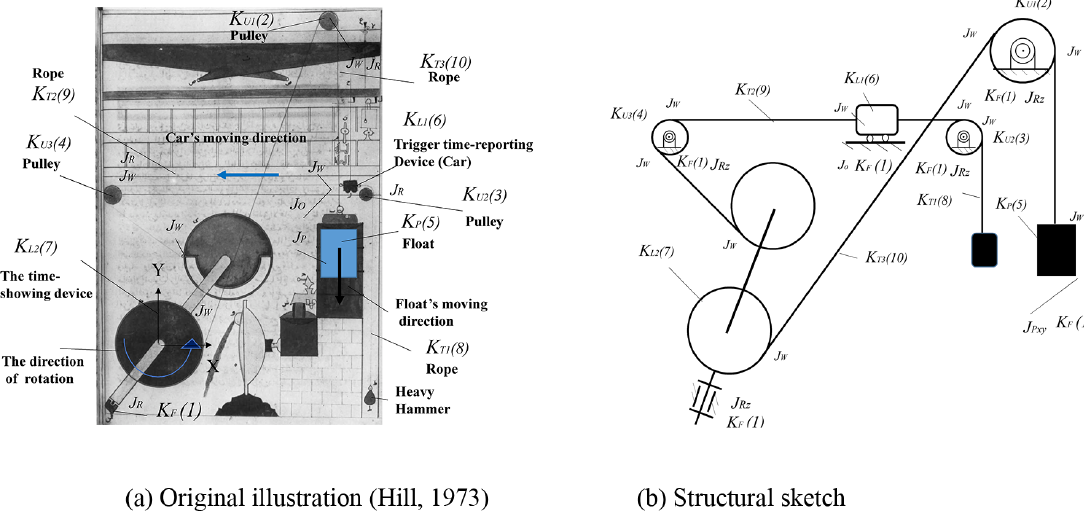
Figure 6. Power transmission system of Al-Jazari’s castle clock.